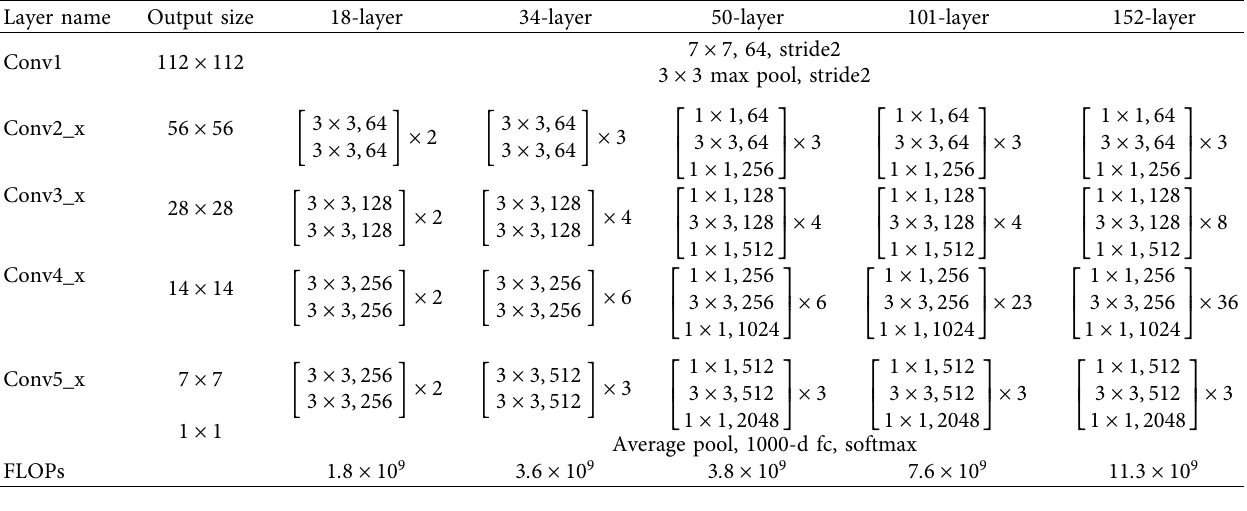
Table 1: Different depths of ResNet.